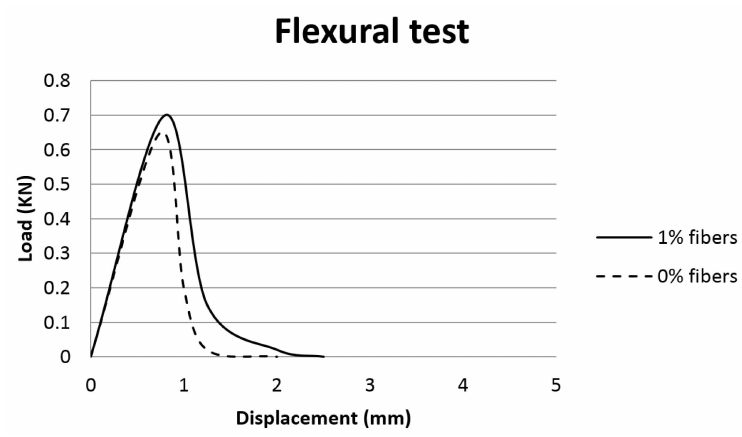
Figure 11. Load-displacement curve of flexural